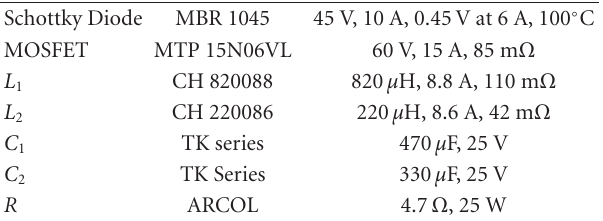
Table 4: Electrical characteristics of the components used in the control circuit board and the measuring